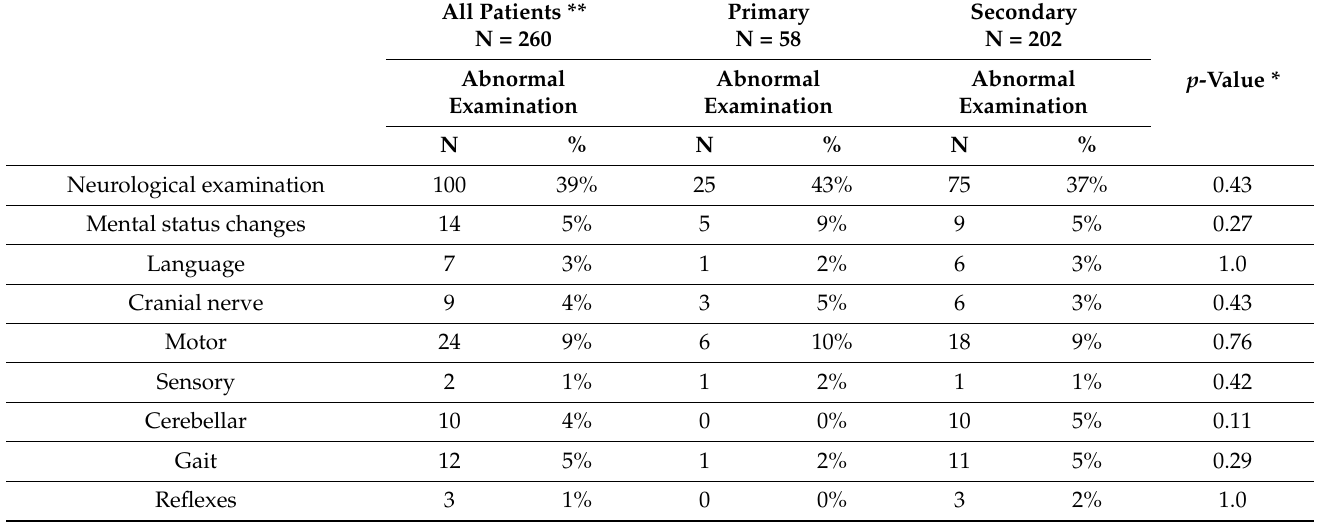
Table 2. Physical Examination Findings.